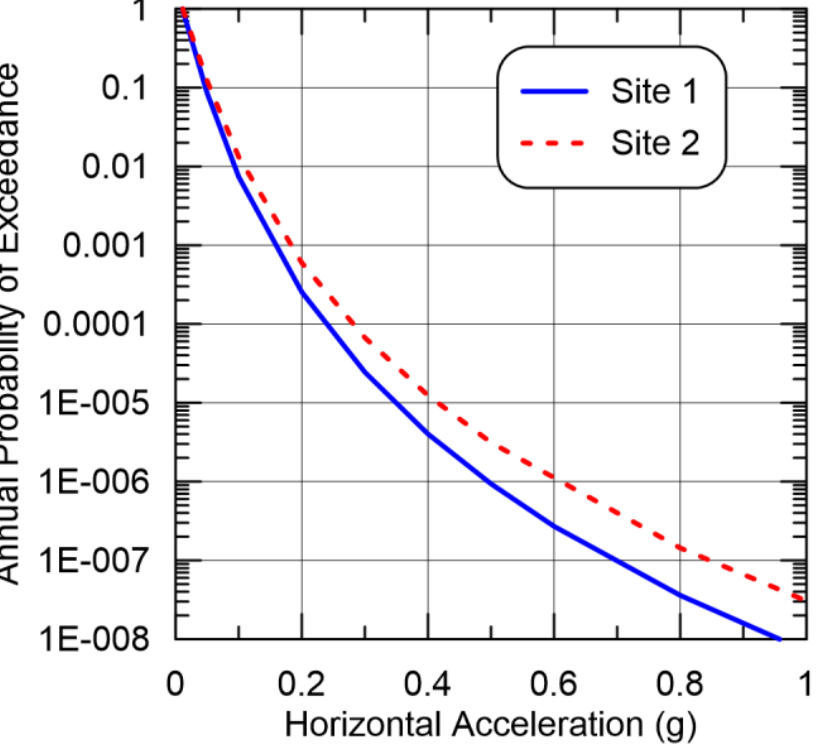
Figure 6. PSHA hazard results for PGA at Sites 1 and 2.